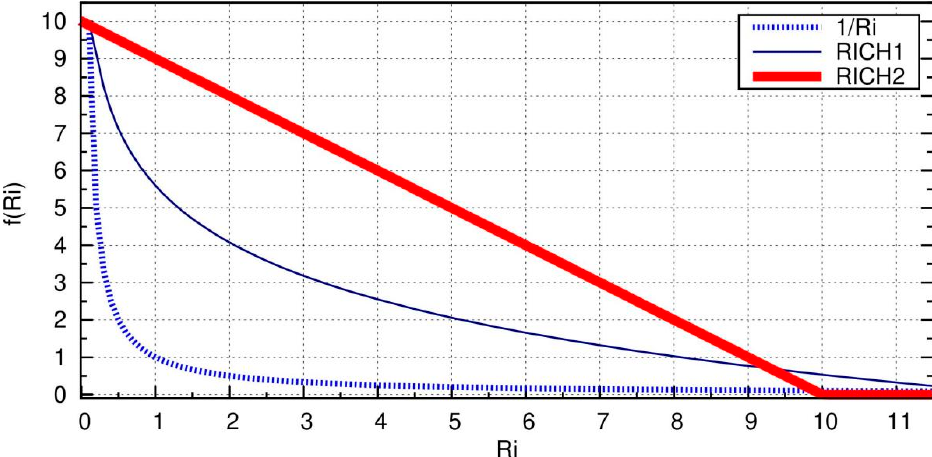
Figure 7. Variation of 1/ R i , RICH1, and RICH2 with R i .